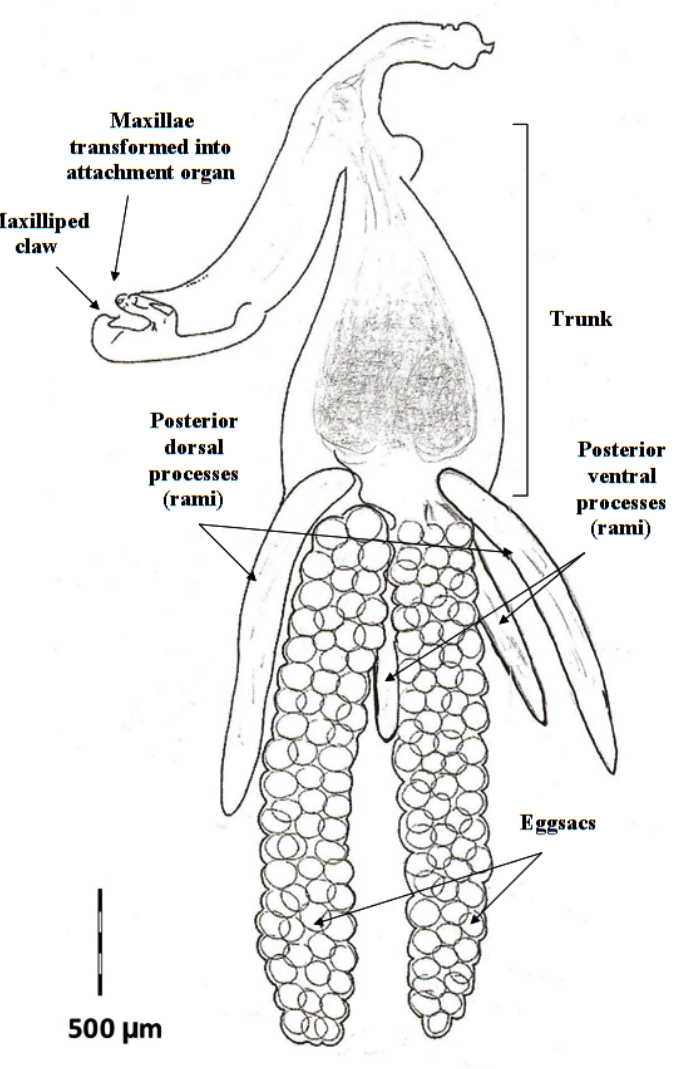
F IGURE 2.- Female Brachiella trichiuri from Trichiurus lepturus .